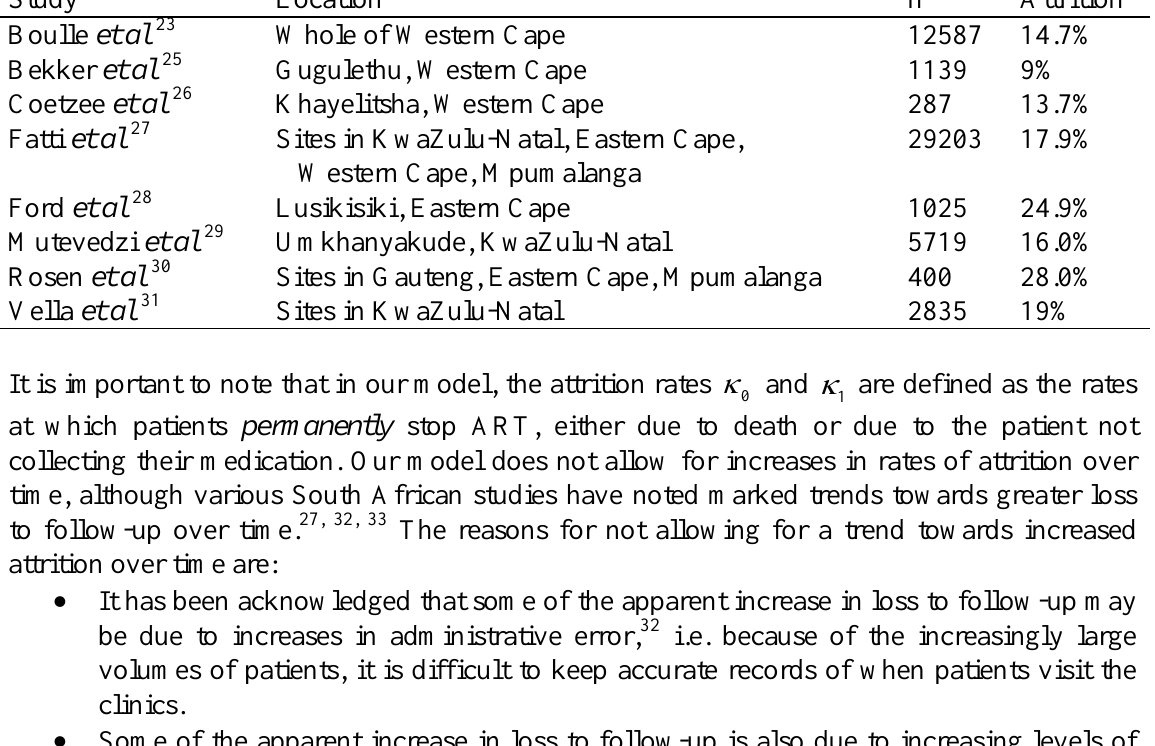
Table 3: Cumulative attrition by 12 months after starting ART in South African patients